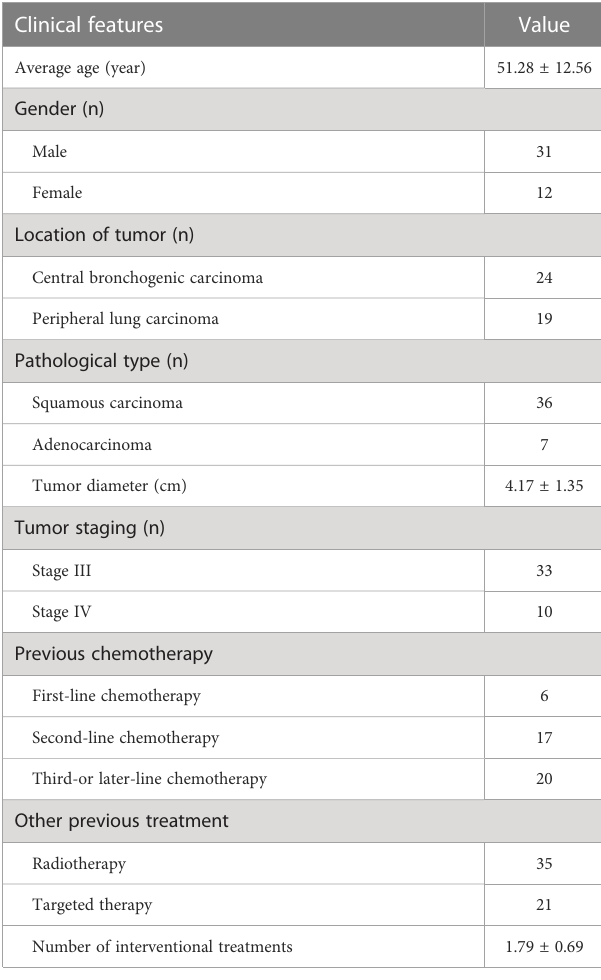
TABLE 1 Clinical features of 43 patients with refractory non-small cell lung cancer. Clinical